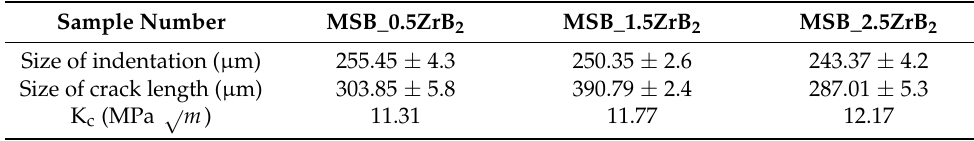
Table 2. Indentation, crack length and K c for selected alloys.